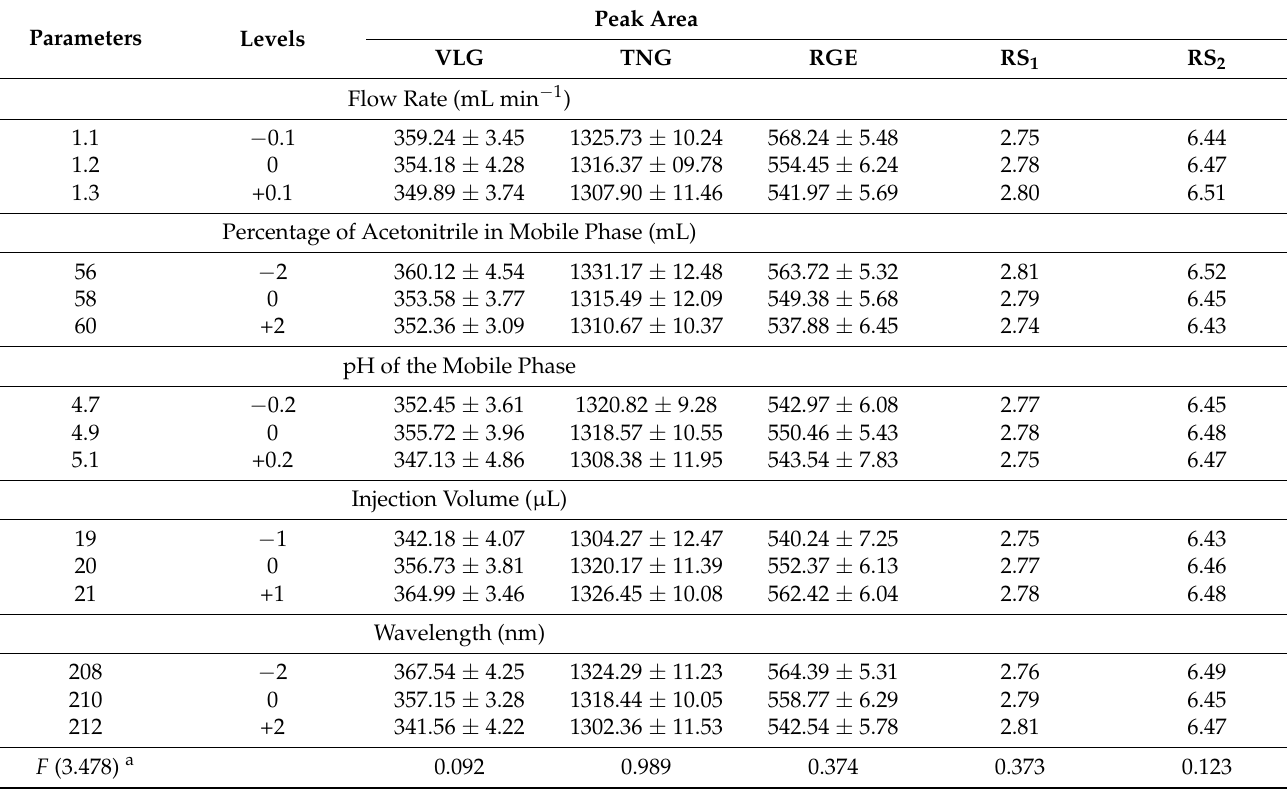
Table 5. Robustness study results.